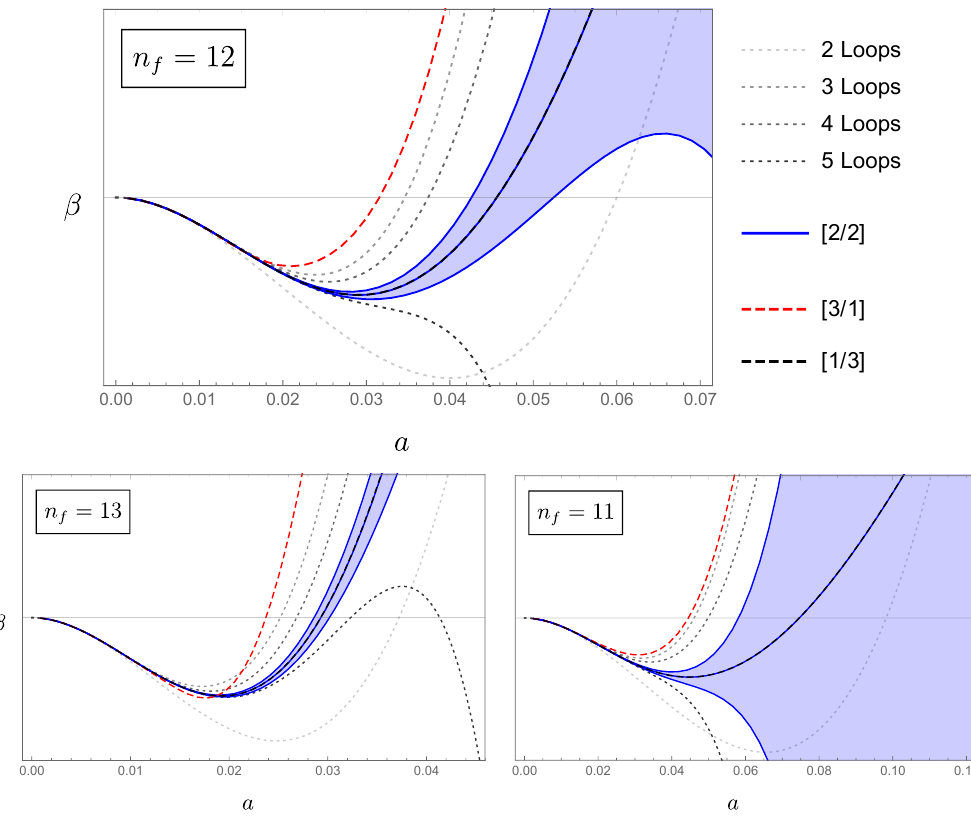
Figure 7 . The QCD (cid:12) -function as a function of the coupling a for n f = 11 ; 12 ; 13 (cid:13)avours. Dotted grey lines correspond to perturbative results, dashed lines denote the central values of the Pad(cid:19)e- Borel approximants [3 = 1] ad [1 = 3] as indicated in the legend. The shaded area corresponds to the error associated to the [2 = 2] approximant and its central value is given by the continuous blu line in the middle. The central values of the [2 = 2] and [1 = 3] approximants are always overlapped. The error band corresponds to c np =